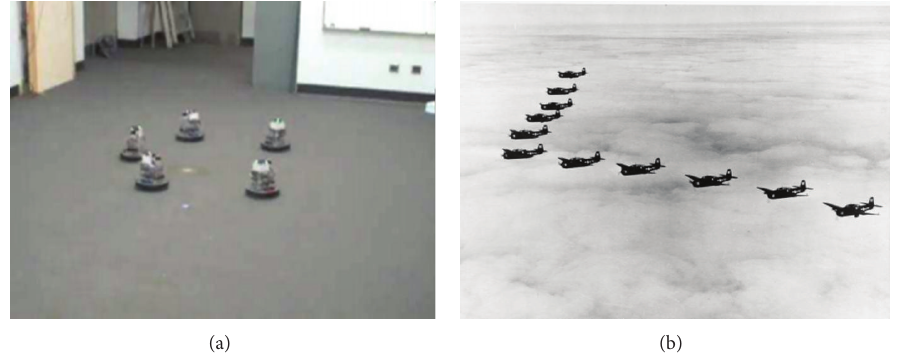
Figure 3: Robots in circular formation and planes in V-formation. Sources: [11, 12].